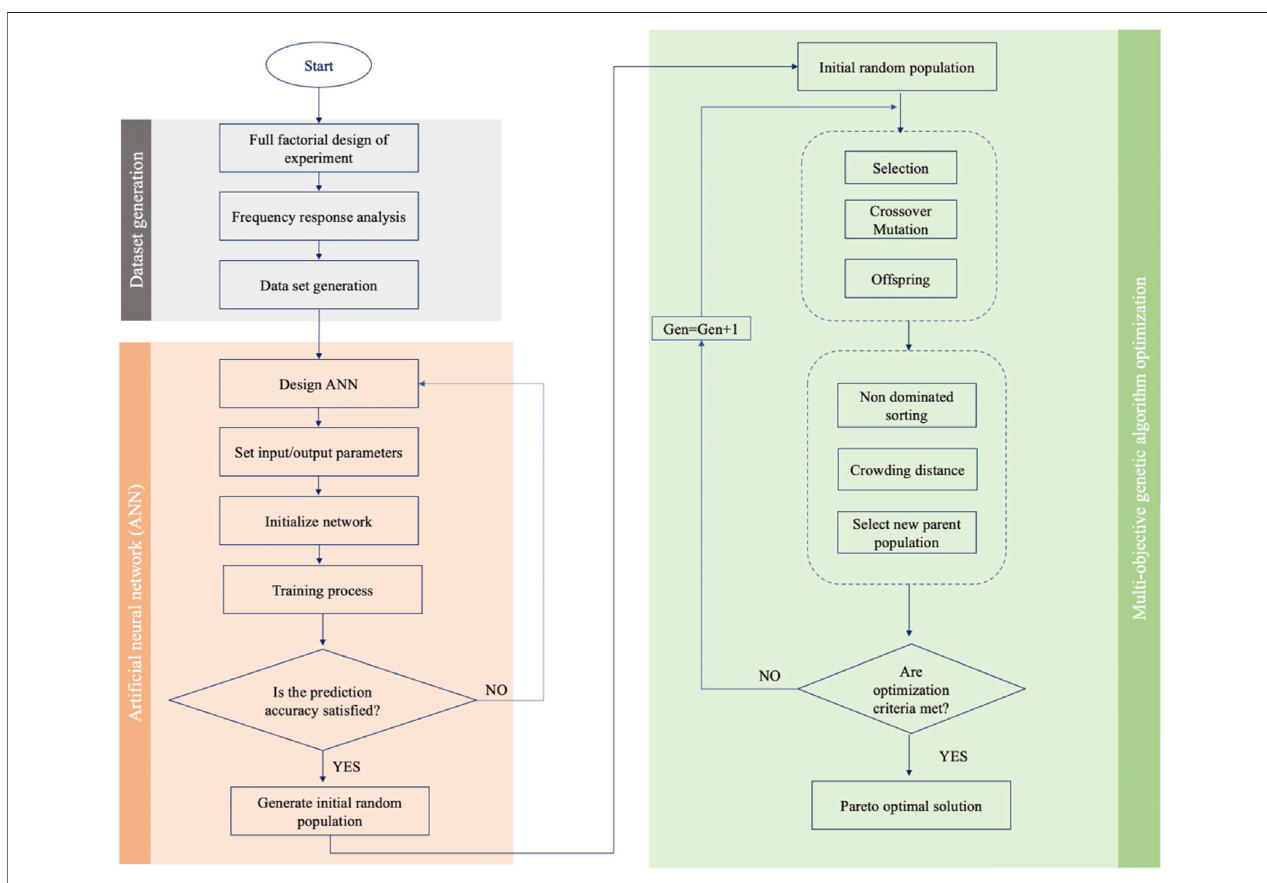
FIGURE 2 | Flowchart of ANN-GA